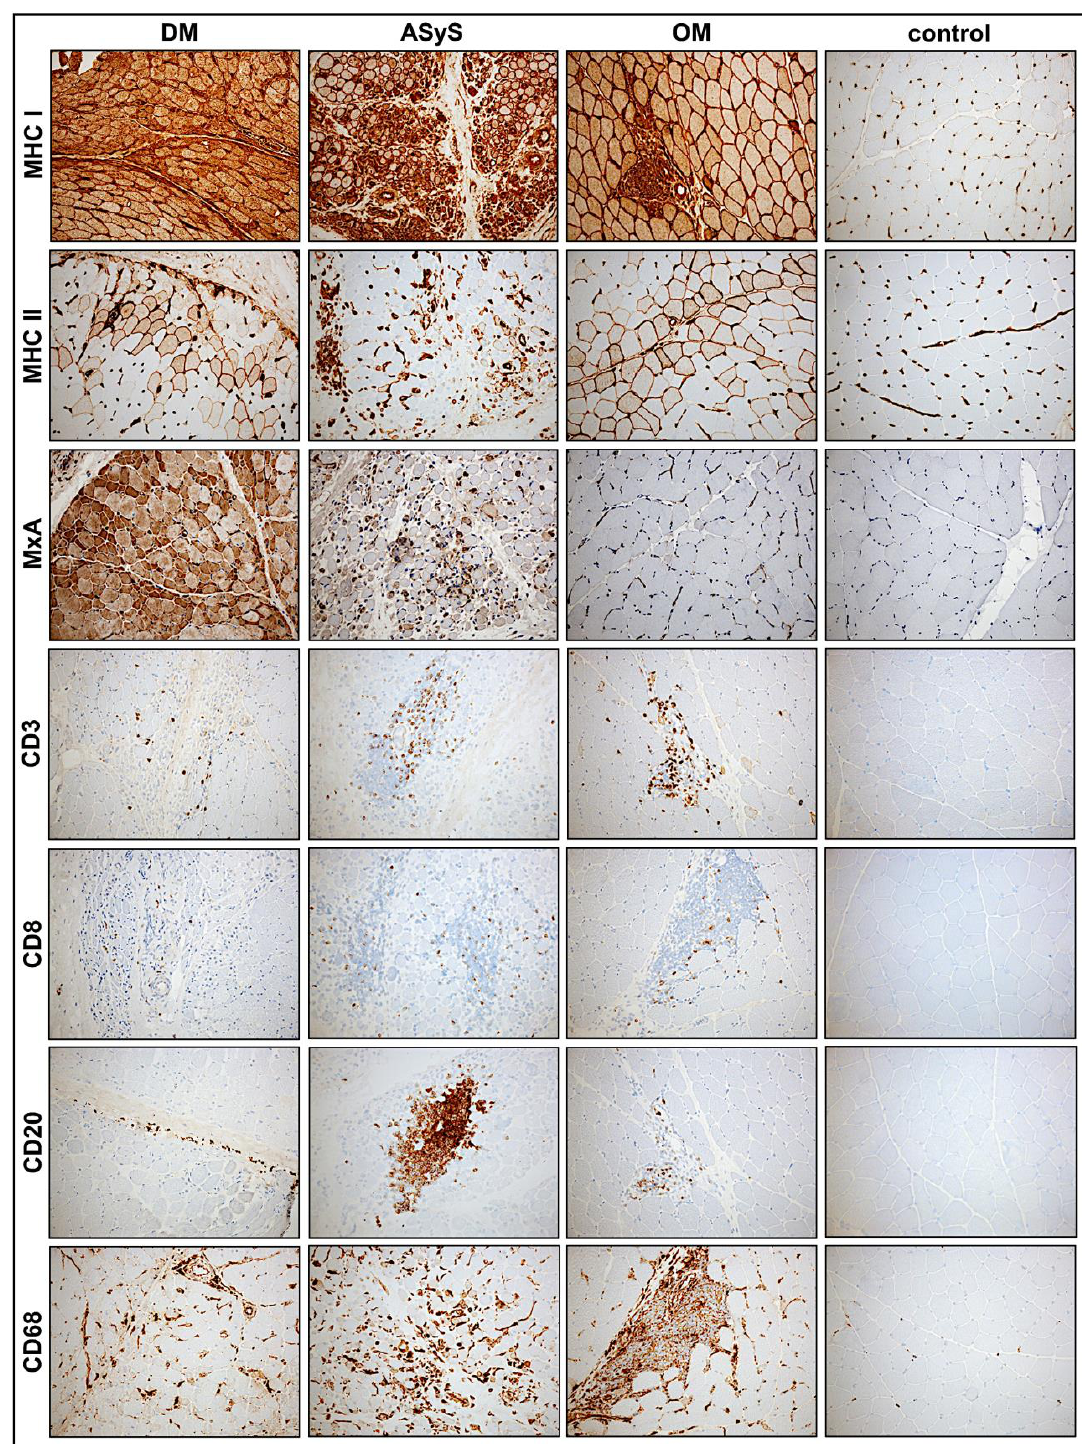
Figure 4. Representative staining of immunohistochemical features of biopsies from patients with DM (P4), anti-Jo1-ASyS (P14), OM (P3), and controls. The upregulation of MHC class 1 on muscle fibers is ubiquitously strong in all IIM subtypes, whereas MHC class II is mainly expressed at perifascicular muscle fibers. Upregulation of MxA is the highest in DM but also present in anti-Jo1-ASyS. Inflammatory cells occur in all subtypes, mainly T-lymphocytes (CD3, CD8). B-lymphocytes (CD20) are prominent in Jo-1-ASyS. Macrophages (CD68) are prominent in all subtypes (magnification 20 × ). (DM = dermatomyositis; ASyS = antisynthetase syndrome; OM = overlap